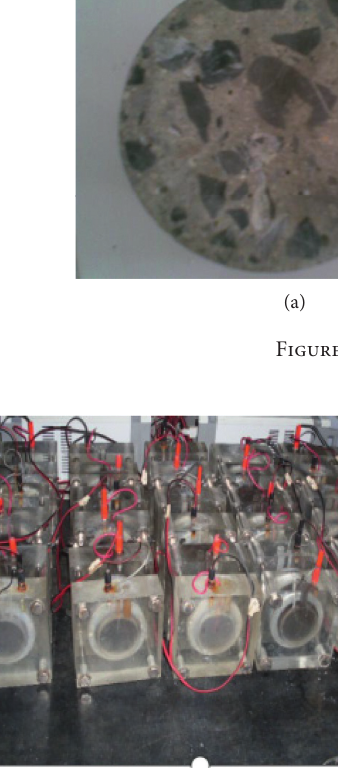
Figure 6: The Autosorb-iQ